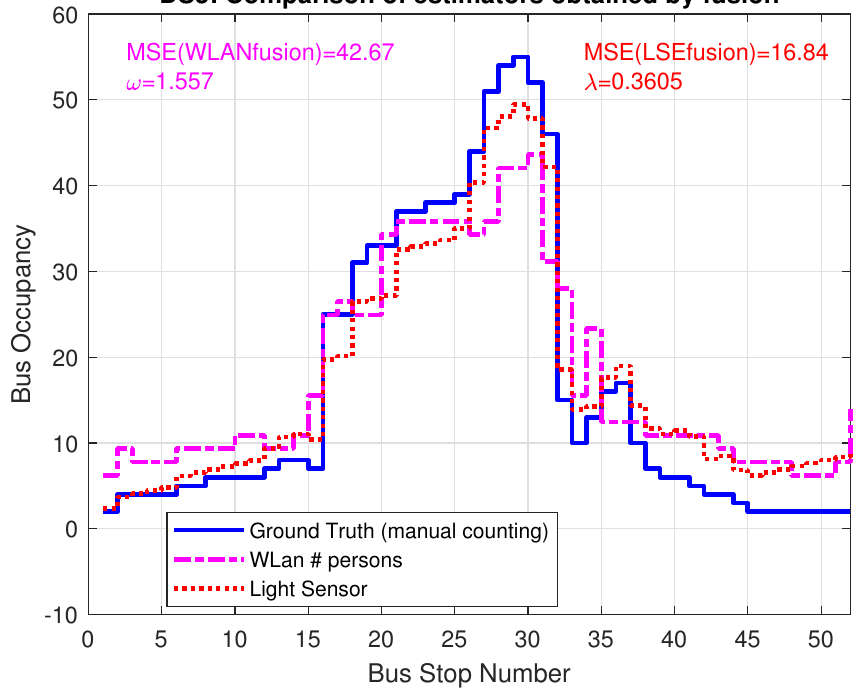
Figure 12. Bus occupancy for corrected models LSE and WLAN for trace DS5, including λ and ω from the fusion